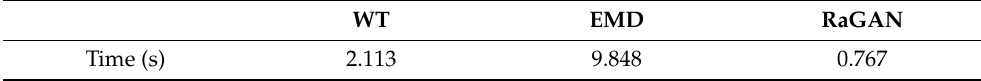
Table 7. Comparison of time spent in processing 1024 noisy signals.